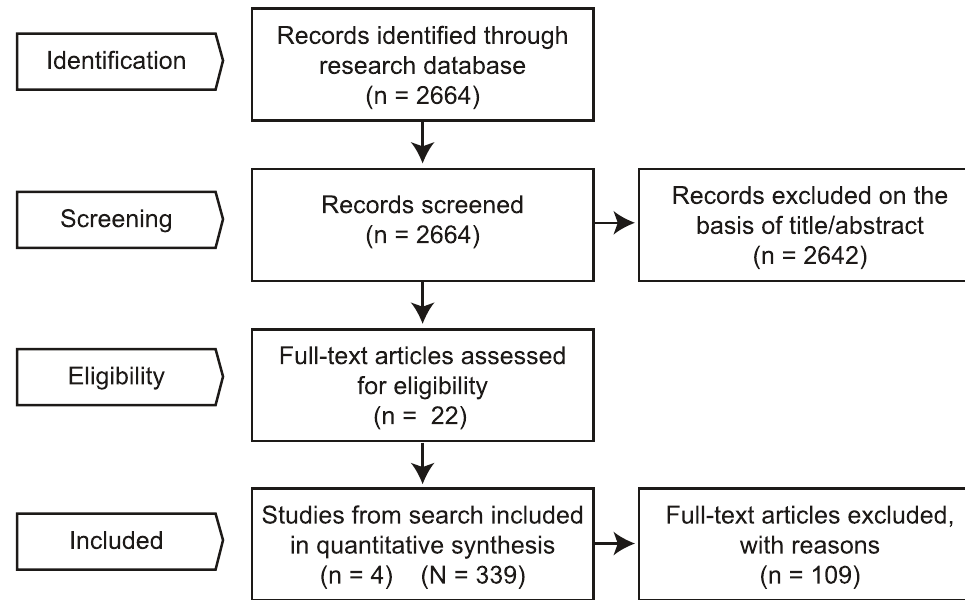
Fig 1. Flow-chart of systematicsearch methodology. n = numberof studies; N = numberof childhoodcancer survivors fulfillingcriteria.